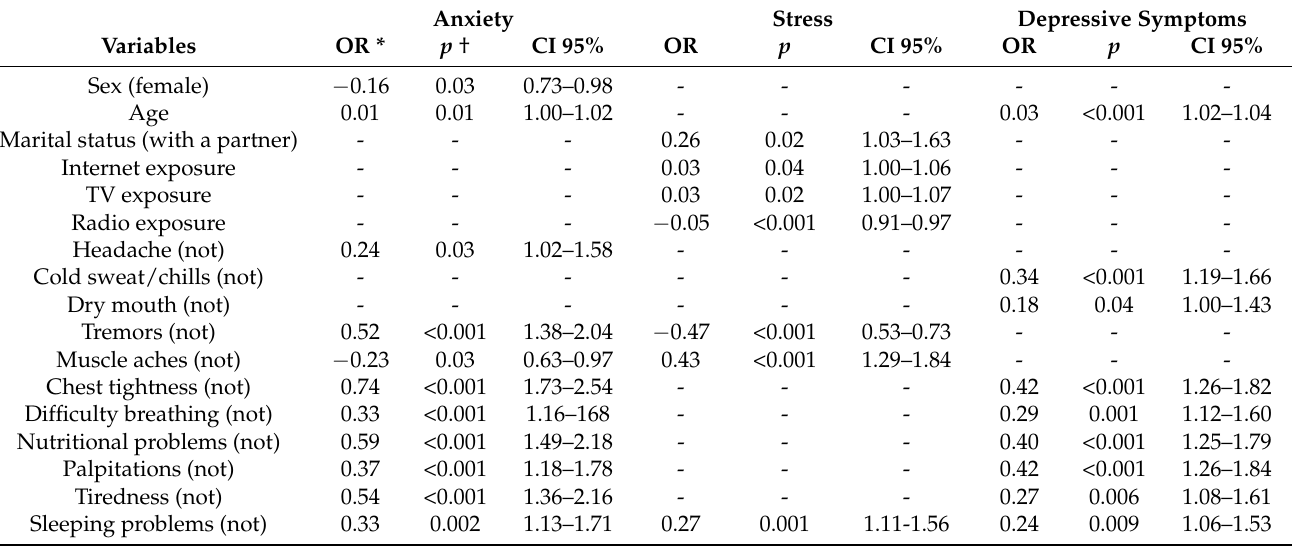
Table 5. Association between anxiety, stress, and depressive symptoms with demographic variables, infodemic, and physical symptoms in the elderly during the COVID-19 pandemic. Peru, 2021. Anxiety Stress Depressive